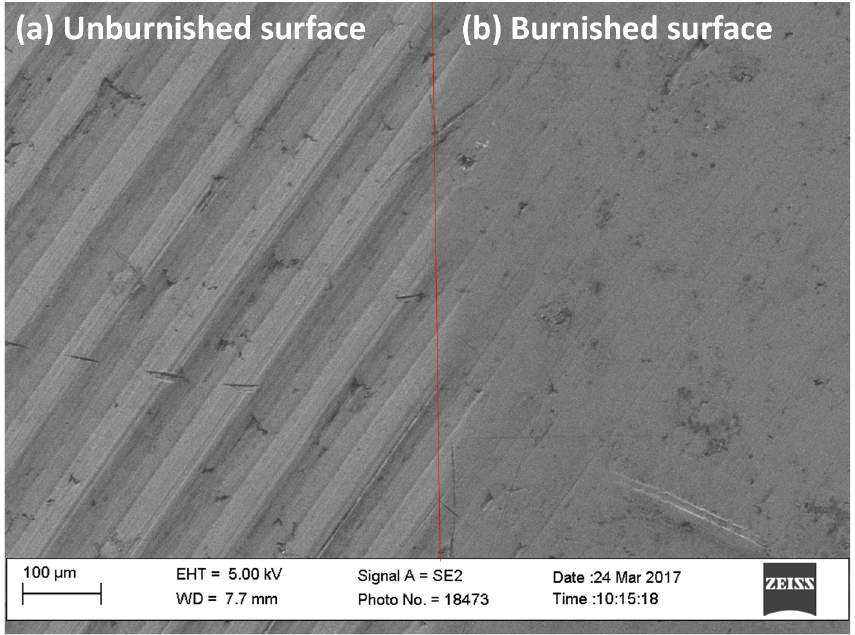
Figure 11. SEM photo of surface topography ( a ) before and ( b ) after burnishing at F = 1650 N, f = 300 mm/min, and S = 0.10 mm.